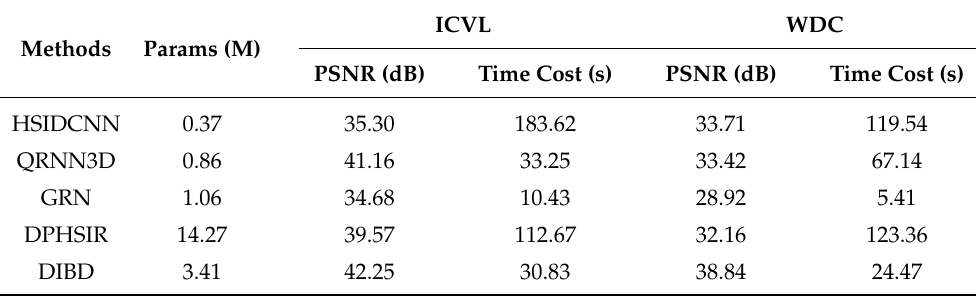
Table 10. The efficiency comparisons of previous SOTA learning-based methods and DIBD on the ICVL and Washington DC